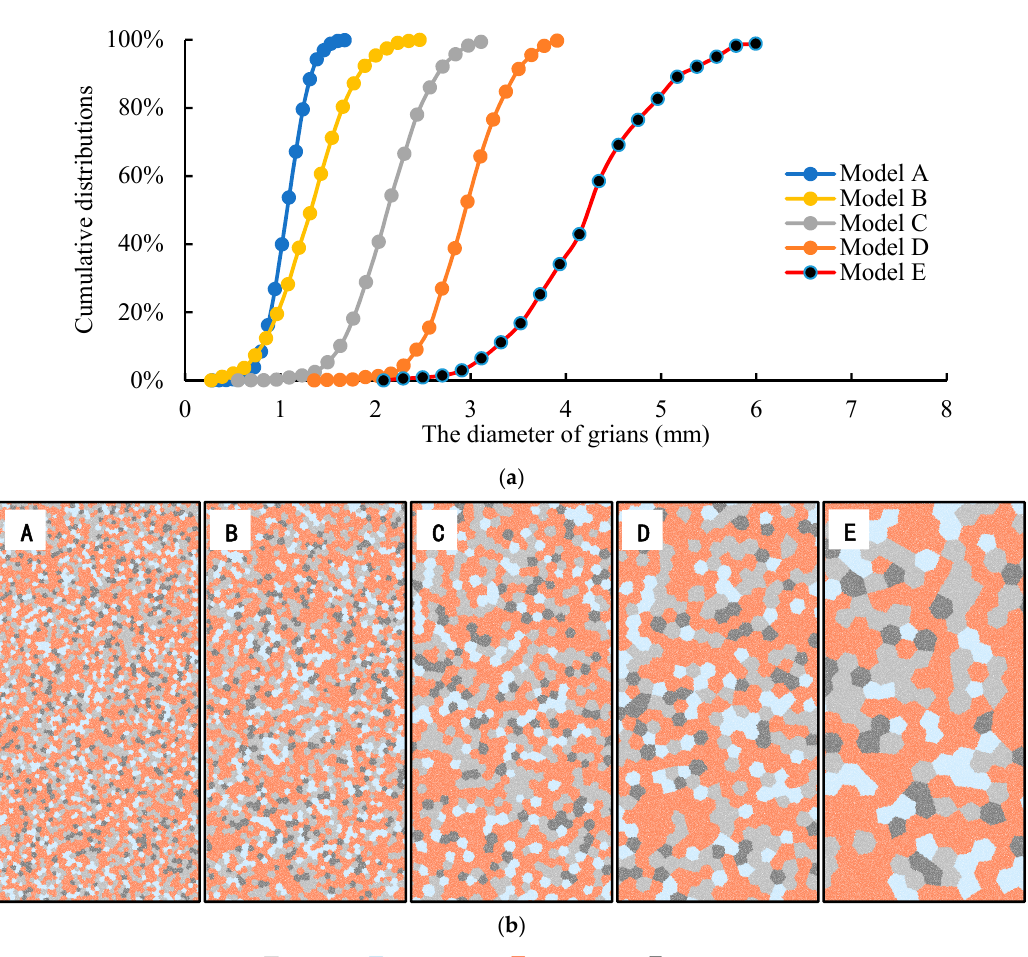
Figure 11. Cumulative distributions of the size of mineral grains in the five models and the corresponding mineral structures. ( a ) Cumulative distributions of the size of mineral grains in the five models; ( b ) Mineral structures in five different models.